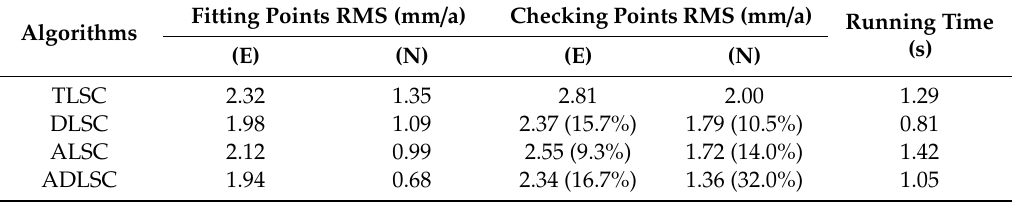
Figure 6. The di ff erent and random selection of checking points in ( a ) experiment 2 and ( b ) experiment. Table 3. RMS of the fitting points and checking points using four algorithms (Experiment 2).